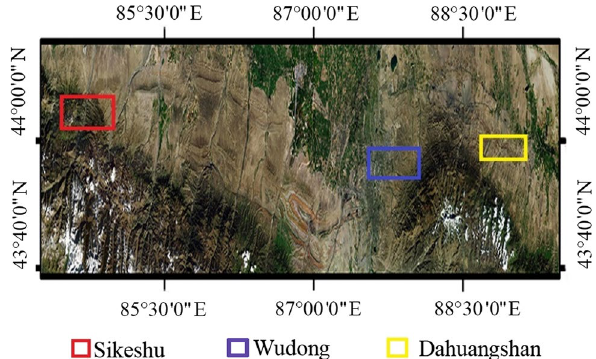
Fig. 1 Location of the study